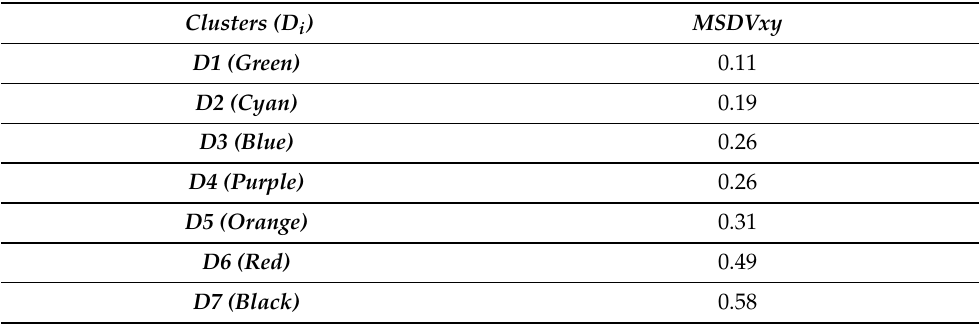
Figure 8. Spider graphs of low ( a ), medium ( b ), and high ( c ) MSDVxy clusters in the models trained with PCA-transformed variables. The visualized variables can be represented with values in the [0, 1] range since they are normalized. The combination of the mean of each variable gives us the characteristic form of each cluster. Table 7. The obtained MSDVxy average values when all samples of each cluster ( D i ) of Solution 2 are